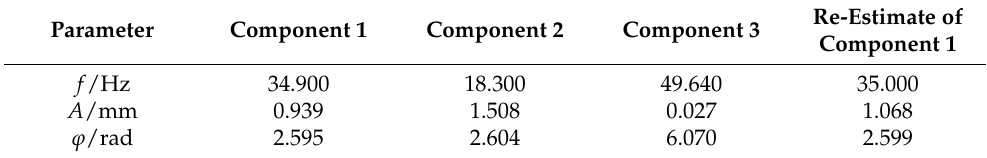
Table 2. Estimate of high-frequency vibration parameters obtained by LS sequential estimators.